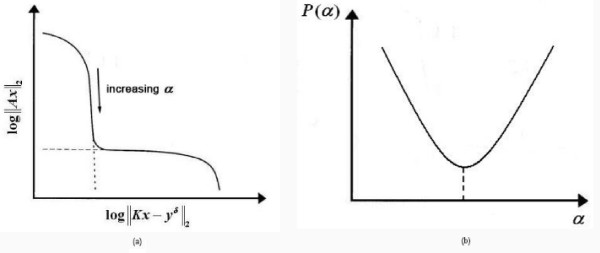
Methods to estimate the regularization parameter. (a) L-curve (b)
                           Minimal Product Curve.